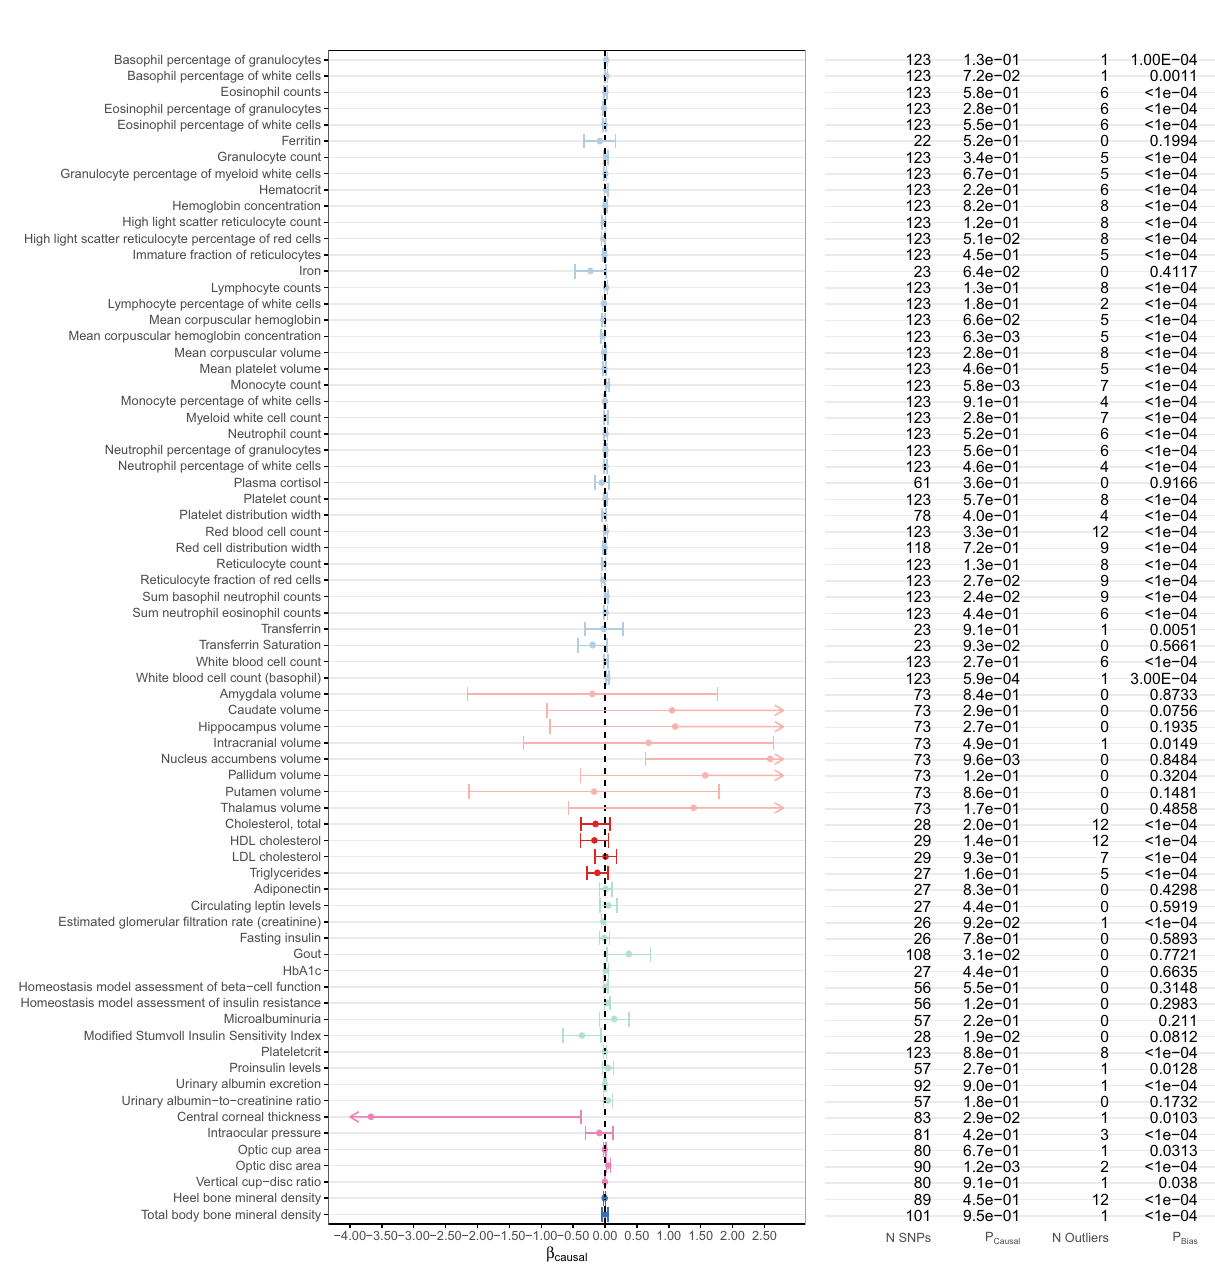
Figure 3. Estimated causal effects of 25(OH)D on biomarkers based on the MR-PRESSO approach using 138 genome-wide significant, conditionally independent SNPs of 25(OH)D. The β causal corresponds to 1 standard deviation increase in log-transformed vitamin 25(OH)D. MR causal estimates for brain imaging outcomes are plotted in z-score scale instead of original β causal